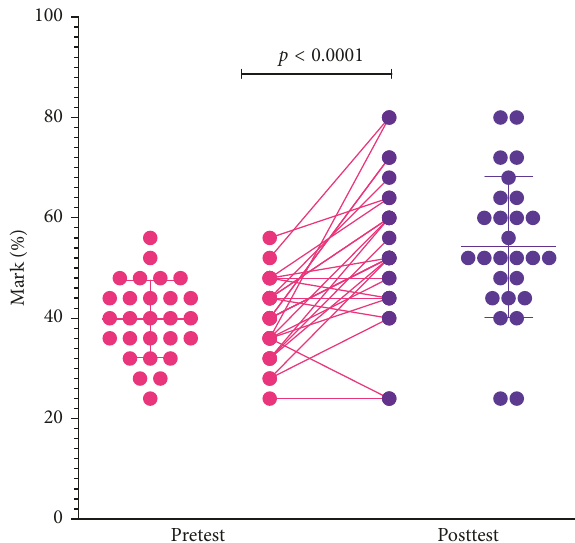
Figure 2: Comparison of pre- and posttest: the figure shows a scatter dot plot of performance of an individual student and matched pre- and posttest scores. There was a statistically significant improvement in the students’ performance in the posttest scores.